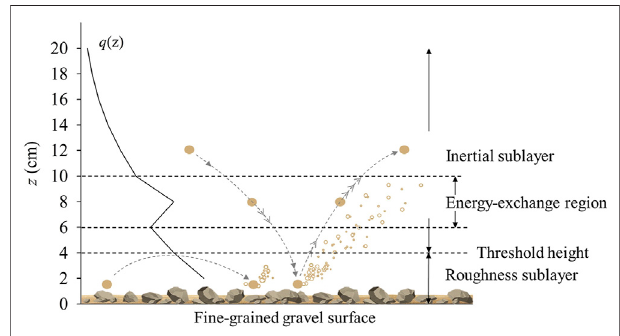
FIGURE 11 | An illustration of structural characteristics of the near- surface air fl ow and sand particle transport in the near-ground surface layer over fi ne-grained gravel surface. The vertical pro fi le of sand fl ux q ( z ) was modi fi ed from Liu and Kimura (2018).